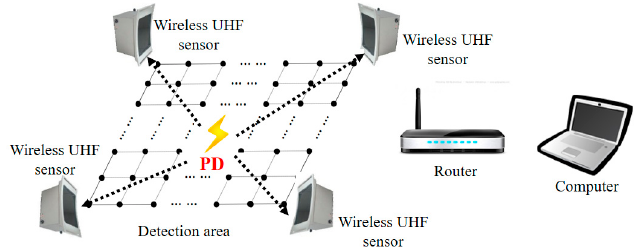
Figure 2. The received signal strength indicator (RSSI) fingerprint PD localization system in substation.